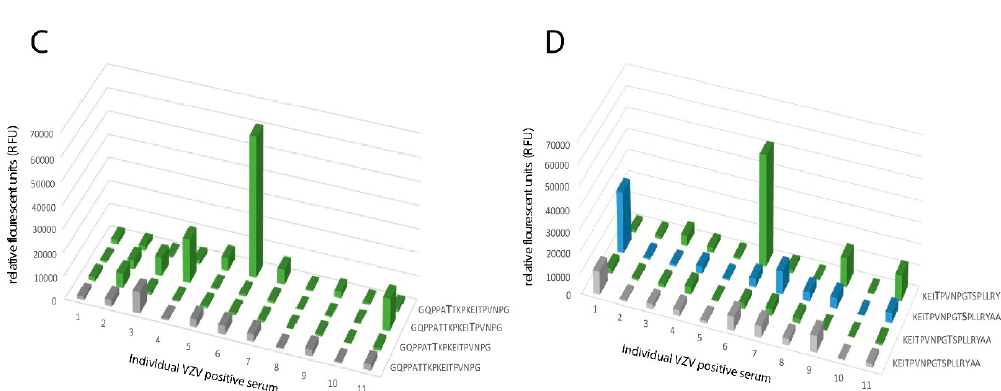
Figure 6. A heterogenous response towards synthetic peptides, with single or multiple GalNAc modifications, was observed for peptides covering parts of gE close to the transmembrane domain, including the MLD domain when individual serum samples were analyzed in detail. ( A ) Synthetic peptide 460-GTTLKFVDTPESLSGLYV-477 unmodified or modified by GalNAc residues at either Ser or Thr. ( B ) Synthetic peptide 505-EERGFPPTAGQPPATTKP-522 unmodified or modified by GalNAc residues at Thr. ( C ) Synthetic peptide 514-GQPPATTKPKEITPVNPG-531 unmodified or modified by GalNAc residues at Thr residues. ( D ) Synthetic peptide 523-KEITPVNPGTSPLLRY-540 unmodified or modified by GalNAc at either Ser or Thr residues. Grey: unglycosylated peptide. Blue: GalNAc modification on a Ser residue. Green: GalNAc modification on a Thr residue. X-axis shows the individual serum samples (n = 11) from VZV IgG-positive patients, plotted in the same order of individual sera in all graphs.